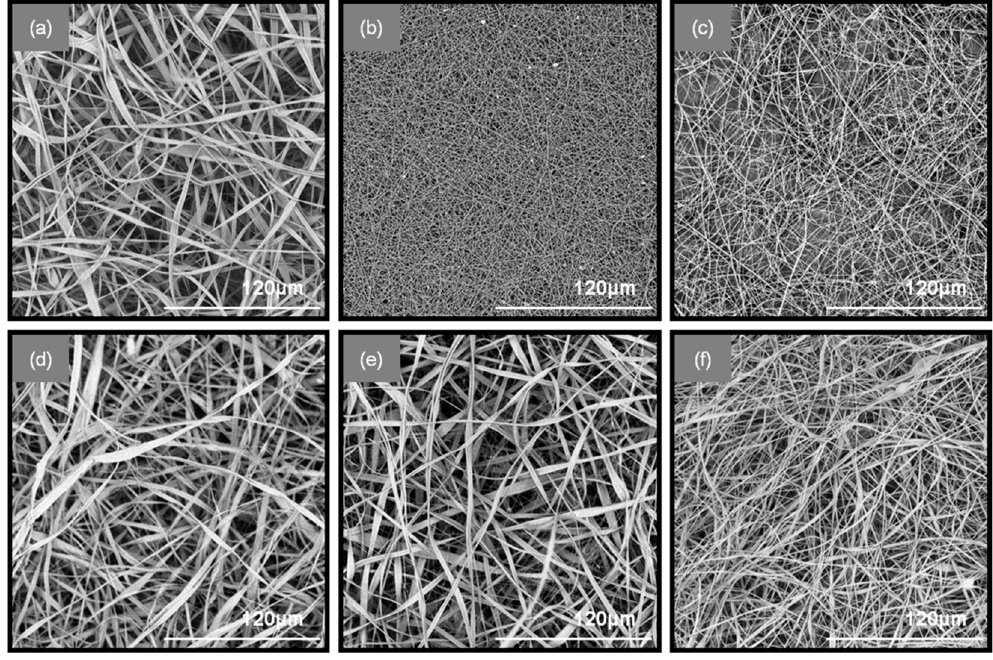
Figure 1. SEM images of ( a ) CA, ( b ) PEO, ( c ) PEO / SA, ( d ) CA-PEO, ( e ) CA-(PEO / SA) and ( f ) (CA / PHBE)-(PEO / SA)-D patches.